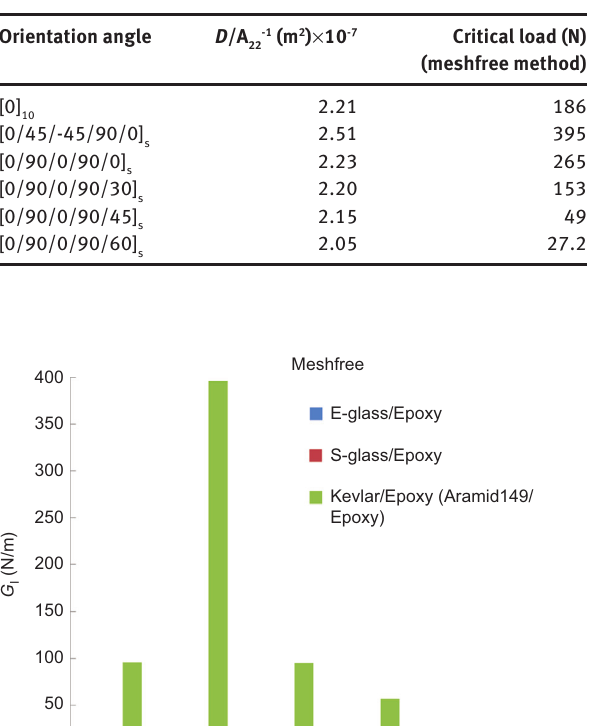
Table 7 Comparison of D / A epoxy laminate (AS4/3501-6) in mode